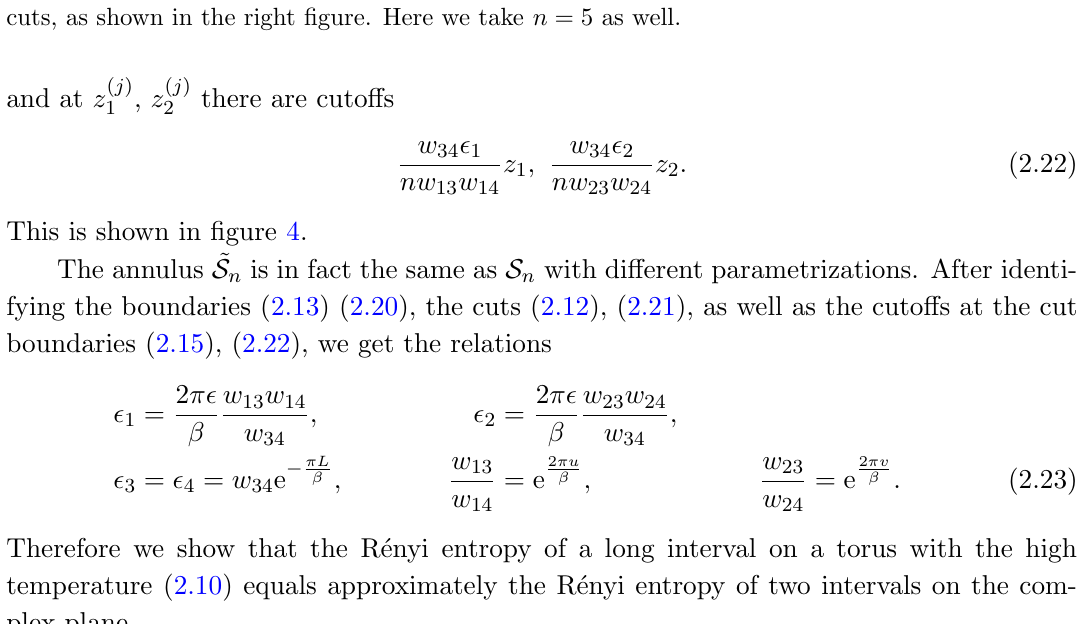
Figure 4 . Illustration on the computation of the R(cid:19)enyi entropy of double intervals on the complex plane. In the left (cid:12)gure we have the original complex plane C with the coordinates w and cuts [ w 4 ; w 3 ] [ [ w 2 ; w 1 ]. Via the replica trick we get the n -fold complex plane C n in the middle (cid:12)gure. For the n -fold complex plane with the coordinate w , we may map it into an annulus ~ S n with